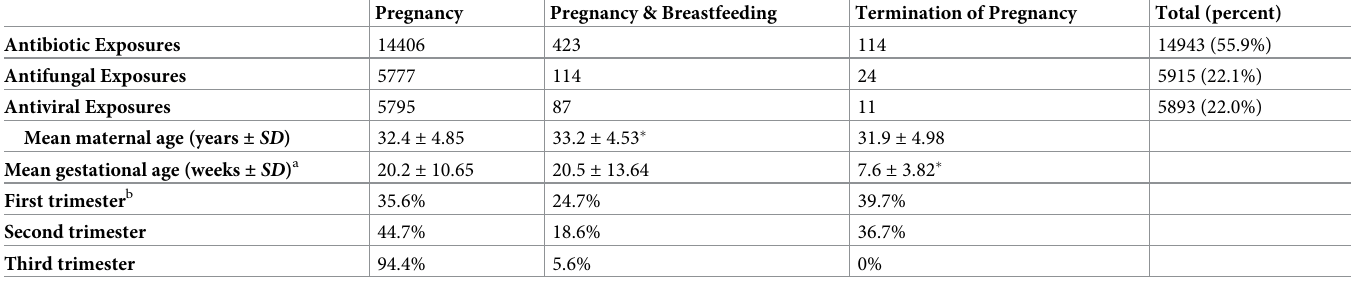
Table 2. Number of enquiries to MotherSafe (2000–2020) regarding anti-infective exposures during pregnancy by reason for call, maternal age, and gestational age. Pregnancy Pregnancy &